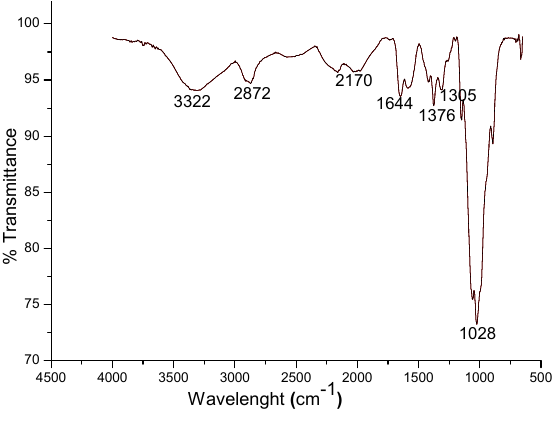
Figure 1. Infrared spectra of the adsorbent. Table 1. Chemical analysis of synthesized chitosan.